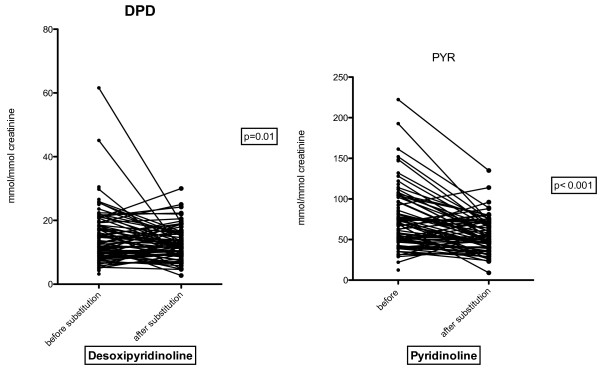
DPD and PYR before and after supplementation.